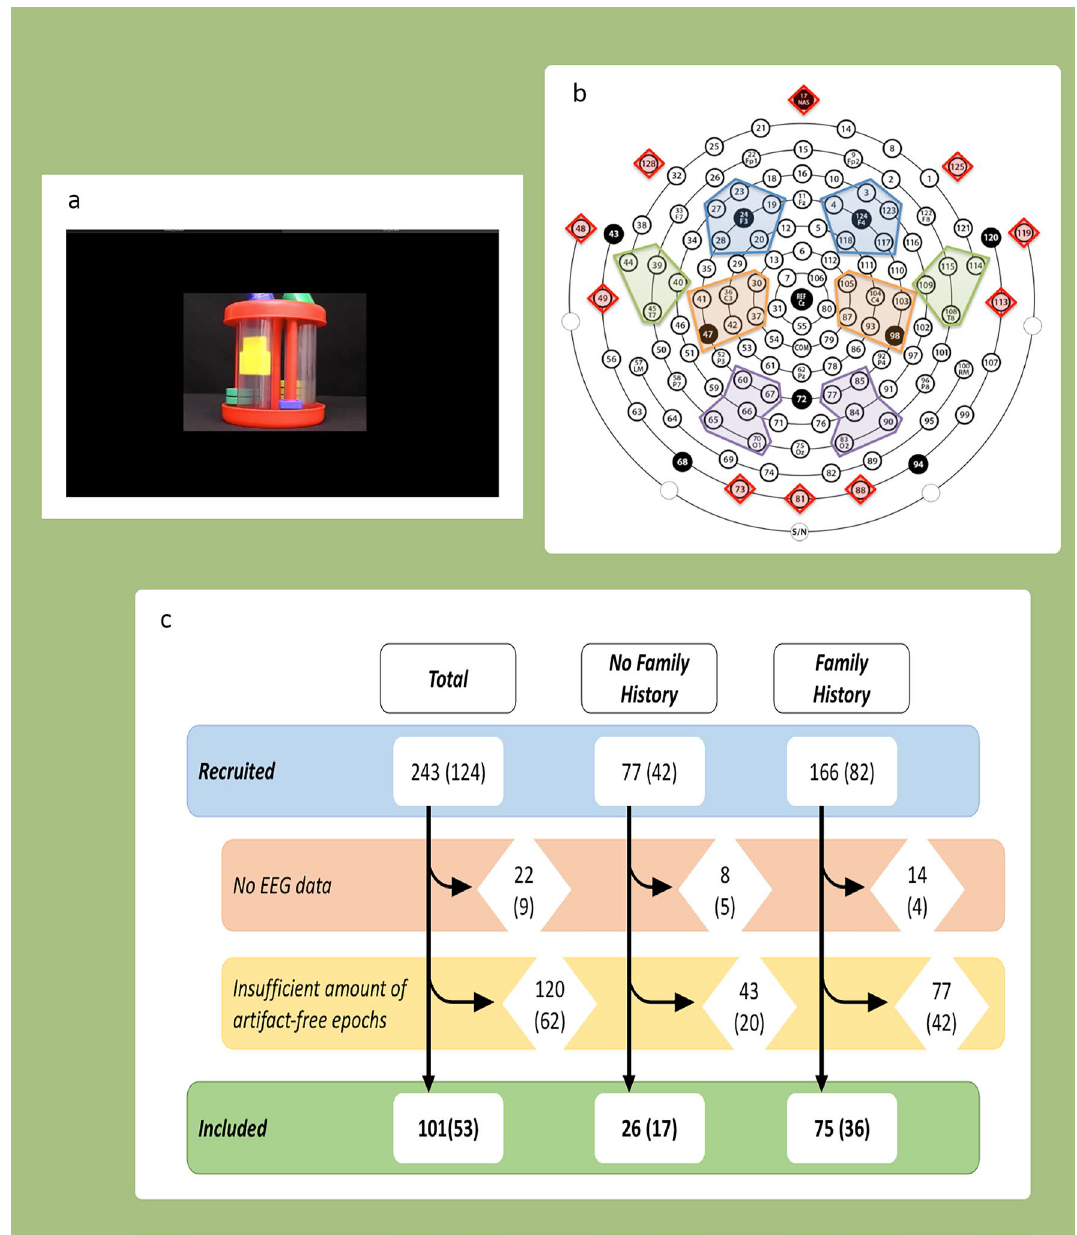
Figure 1. Paradigm and attrition rates. ( a ) Screenshot of one of the toy dynamic videos. ( b ) Top view of the layout of the EEG high-density net. Electrodes on the outer rim were excluded since these were bad during the recording (red diamonds). Spectral theta power was calculated for frontal (blue), parietal (orange), temporal (green), and occipital (purple) regions (after 34 ). ( c ) Attrition rates for the samples included in the